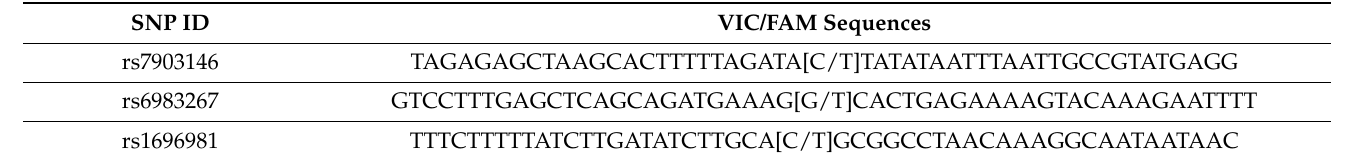
Table 1. VIC/FAM Sequences of SNP Genotyping Assay.